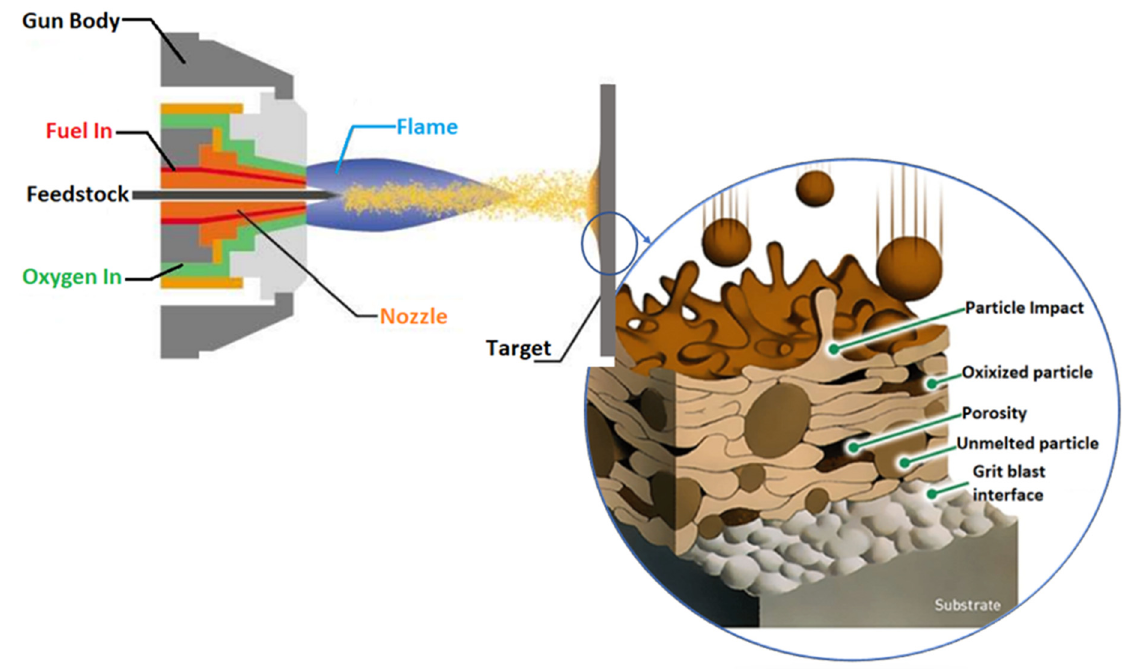
Figure 6. Illustration of a thermal spray process with a magnified image highlighting various features in the coating. Reprinted with permission from [127] Copyright 2020 Elsevier.